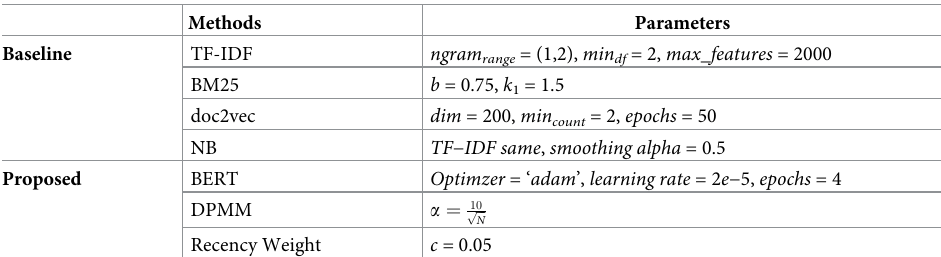
Table 4. Selective hyperparameters used in baseline vs. our proposed